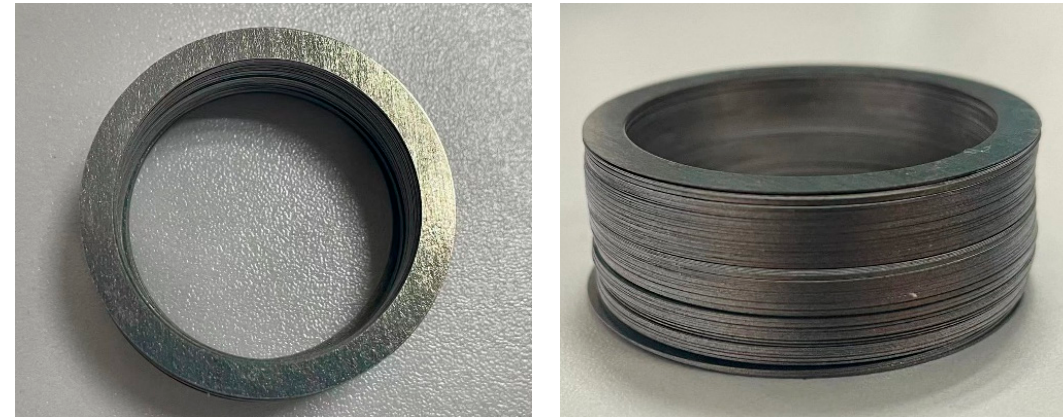
Figure 17. Laser cutting shaped ring test specimen.